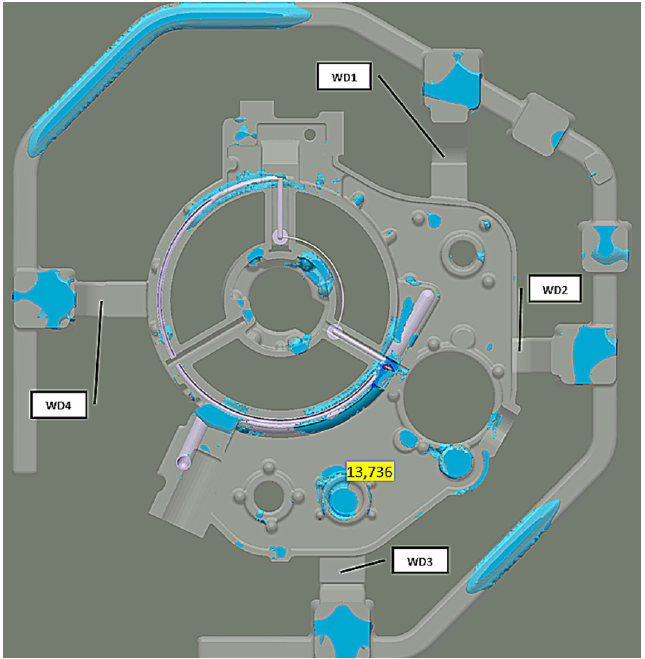
Figure 10. Stage 2 Porosity in the feeding gate areas.